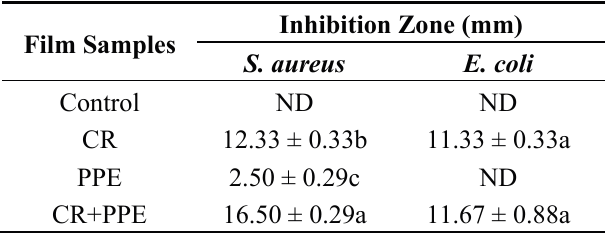
Table 3. Antibacterial activity expressed as the inhibition zone diameter (mm) of chitosan films incorporated with pomegranate peel extract and